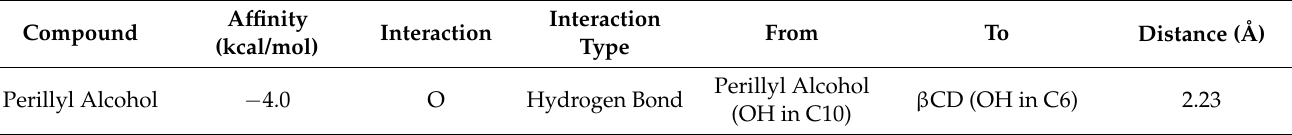
Figure 1. ( A ) and ( B ) β -CD structure, ( C ) and ( D ) molecular docking between POH and β -CD. Table 1. Molecular docking affinity energy and interaction groups calculated using AutoDock vinna for the POH/ β CD complex.